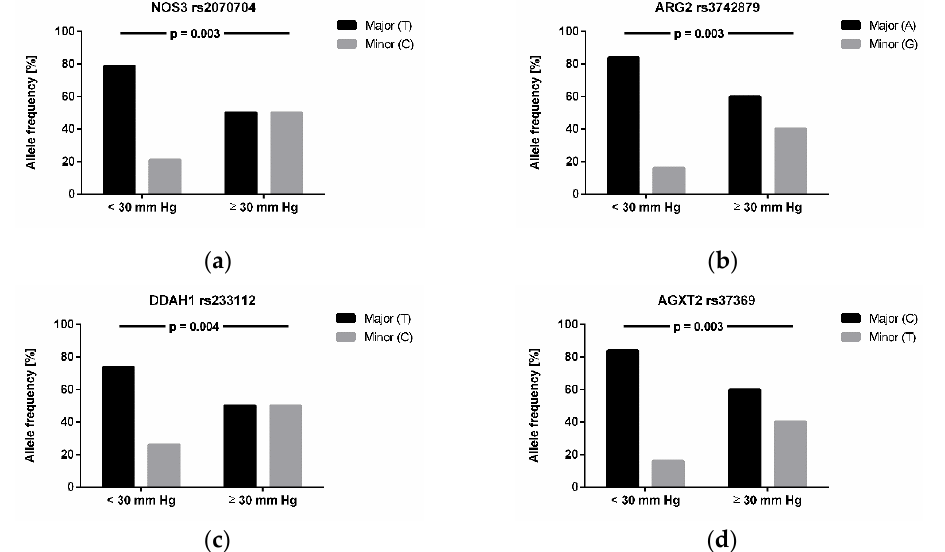
Figure 3. Relationship of genotypes of ( a ) NOS3 rs2070704, ( b ) ARG2 rs3742879, ( c ) DDAH1 rs233112, and ( d ) AGXT2 rs37369 with high-altitude pulmonary hypertension. Mean pulmonary arterial pressure was estimated by echocardiography after 6 months of chronic intermittent hypoxia in n = 24 individuals. Allele frequencies were analysed in individuals with (i.e., mPAP ≥ 30 mm Hg) or without high-altitude pulmonary hypertension (i.e., mPAP < 30 mm Hg). Data given are relative allele frequencies of the genes indicated. p values indicate significances in χ 2 test after adjustment for multiple testing.